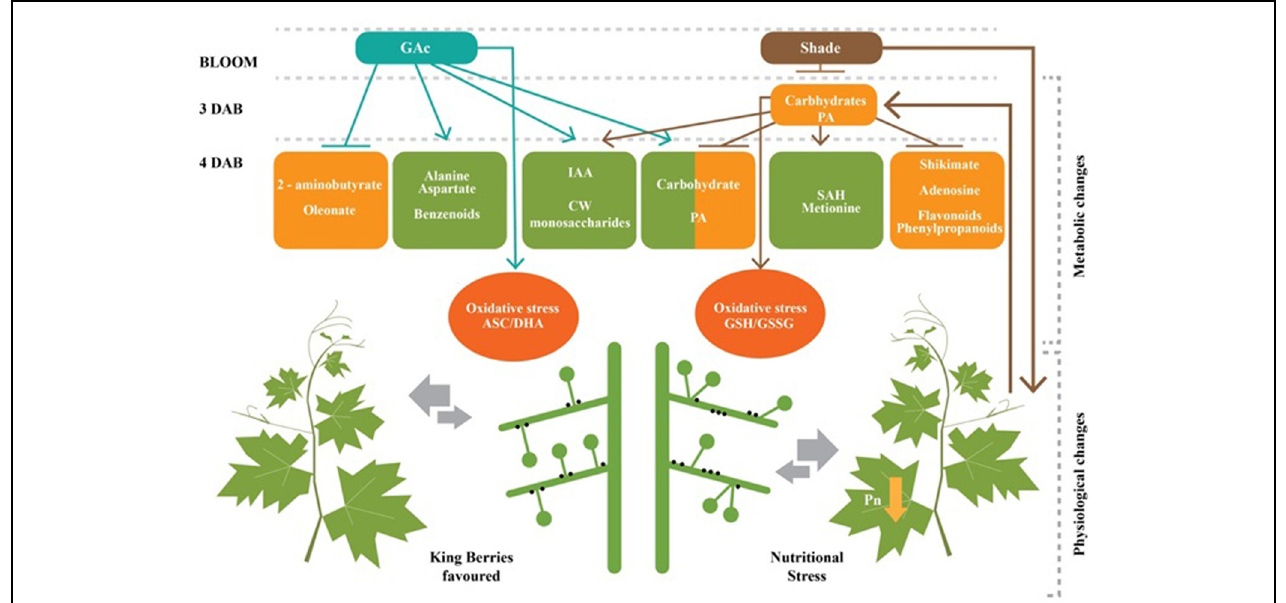
FIGURE 7 | A proposed mechanistic model for flower abscission in Vitis Vinifera L. inflorescences triggered by GAc and shade. Shade treatment reduced net photosynthetic rate which lead to significant alterations 3 and 4 DAB, including global carbohydrates starvation, reduction on shikimate, PA (putrescine) and secondary metabolisms and increase of oxidative stress, revealed by glutathione remediation cycle. GAc induced an increase on carbohydrates, PA (putrescine), amino acids and secondary metabolisms and oxidative stress, revealed by ascorbate/dehydroascorbate remediation couple at